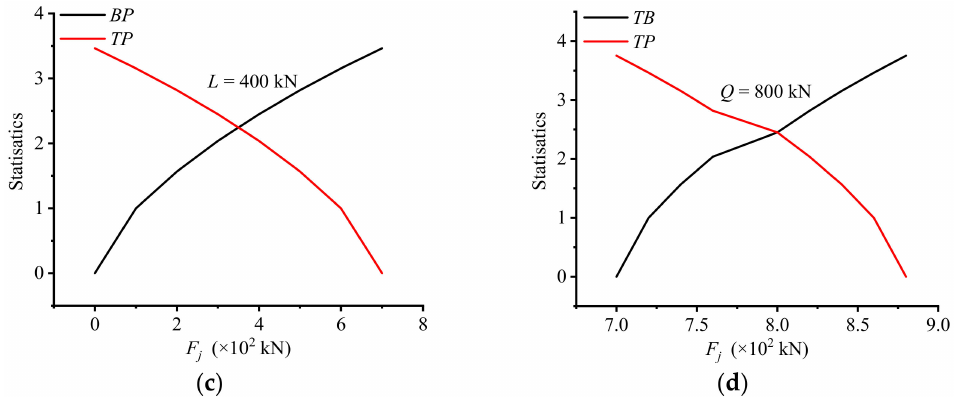
Figure 6. The E j ,norm - F j and M-K statistic curves of CFST arch support-A: ( a ) the E j ,norm - F j curve of CFST arch support-A; ( b ) the M-K statistic curves of CFST arch support-A between 0 kN and 880 kN; ( c ) the M-K statistic curves of CFST arch support-A between 0 kN and 700 kN; ( d ) the M-K statistic curves of CFST arch support-A between 800 kN and 880